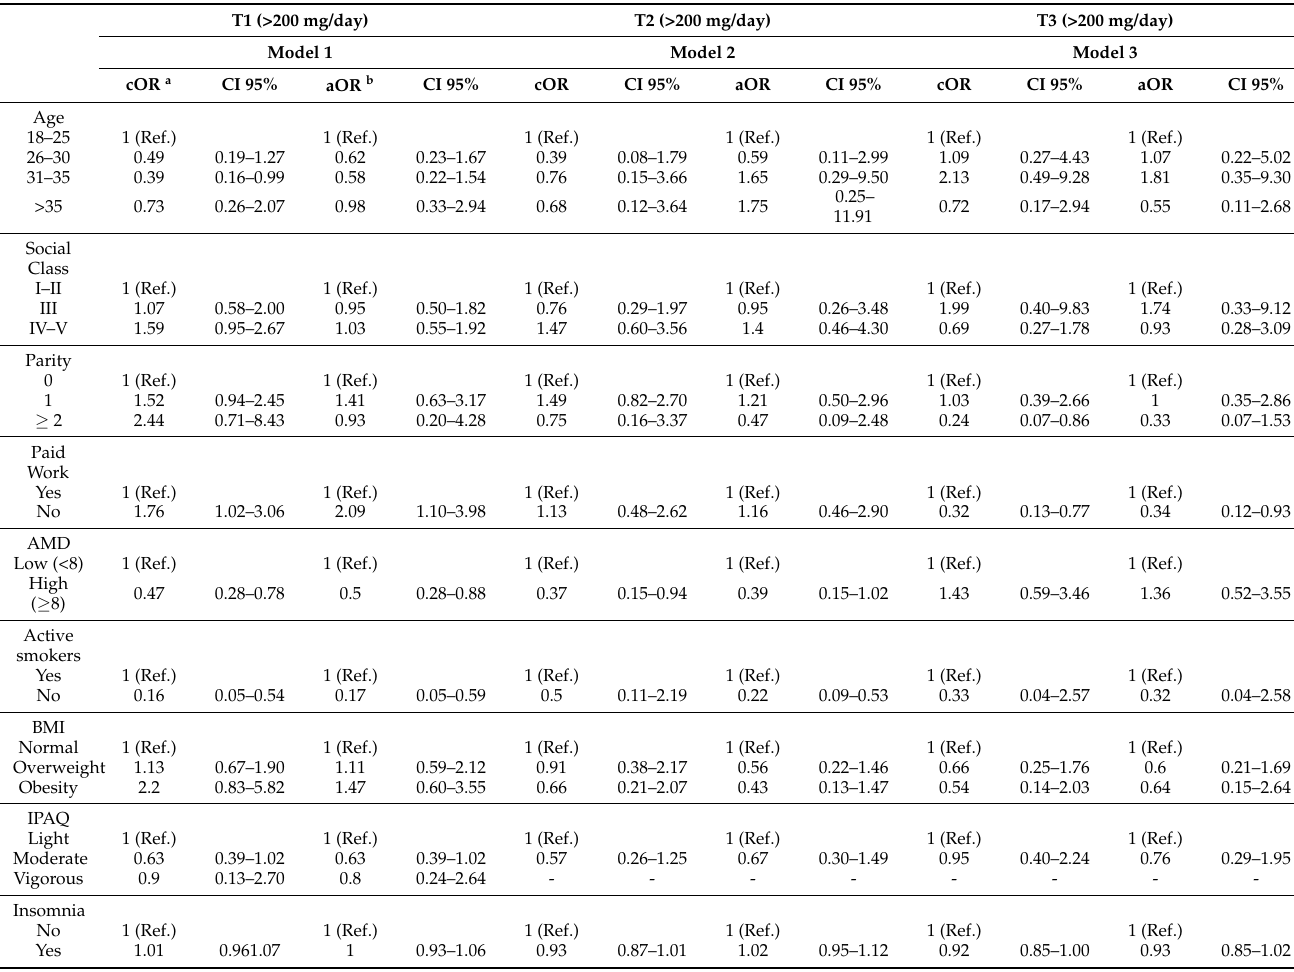
Table 3. Logistic regression of factors associated with non-compliance with caffeine intake recom- mendations throughout